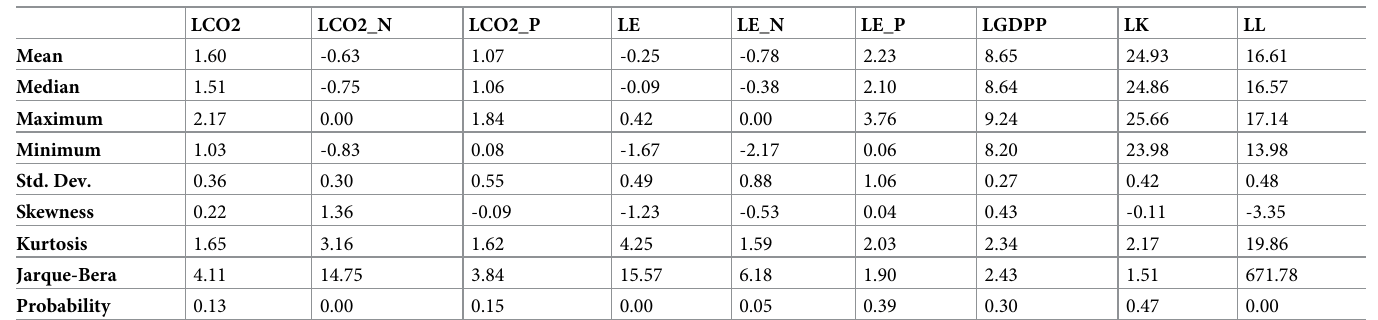
Table 1. Descriptive analysis of data.